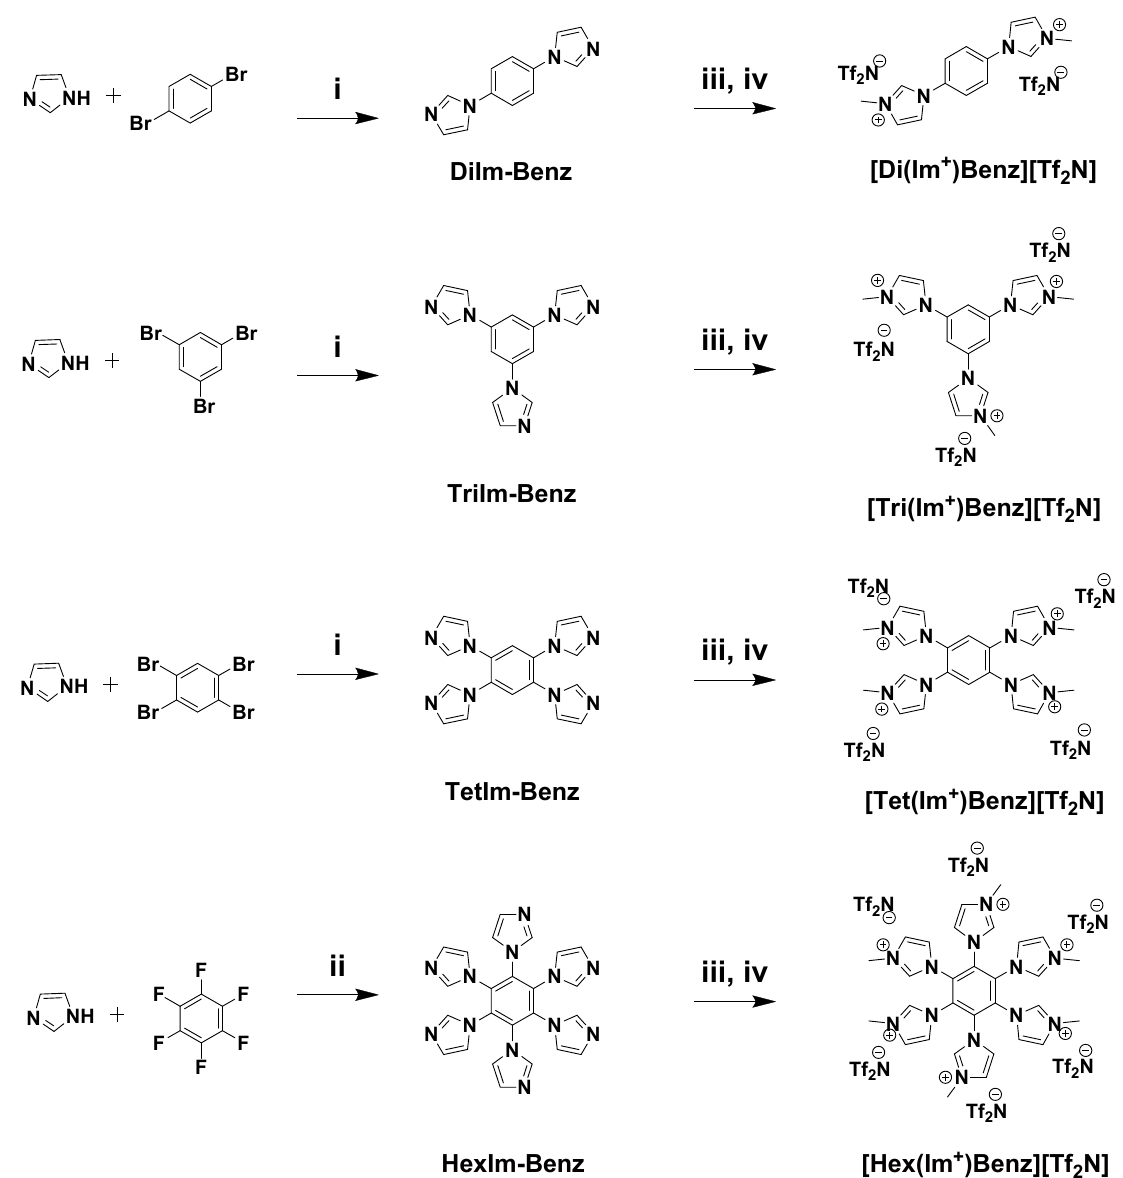
Scheme 1. Imidazolium-benzene derived multivalent di-, tri-, tetra-, and hexa- imidazolium bistriflimide fillers. (i) K 2 CO 3 , CuSO 4